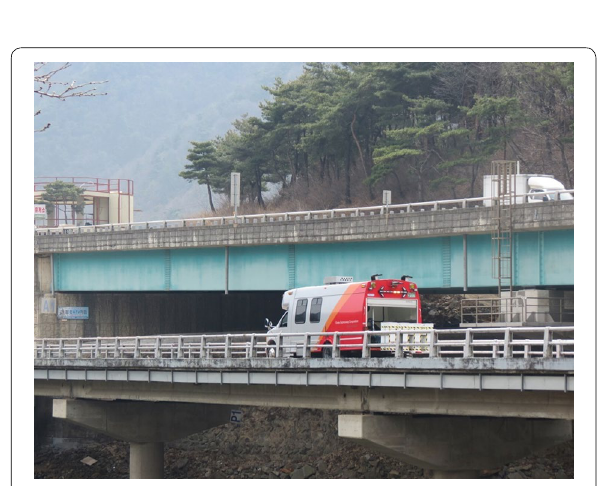
Fig. 8 Photo of air‑coupled GPR system used for concrete bridge deck survey in this